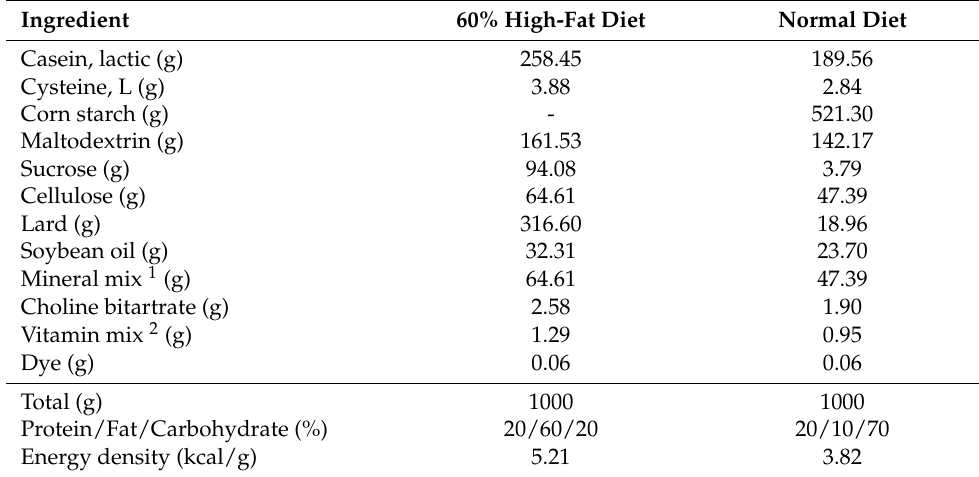
Table 4. Compositions of the experimental